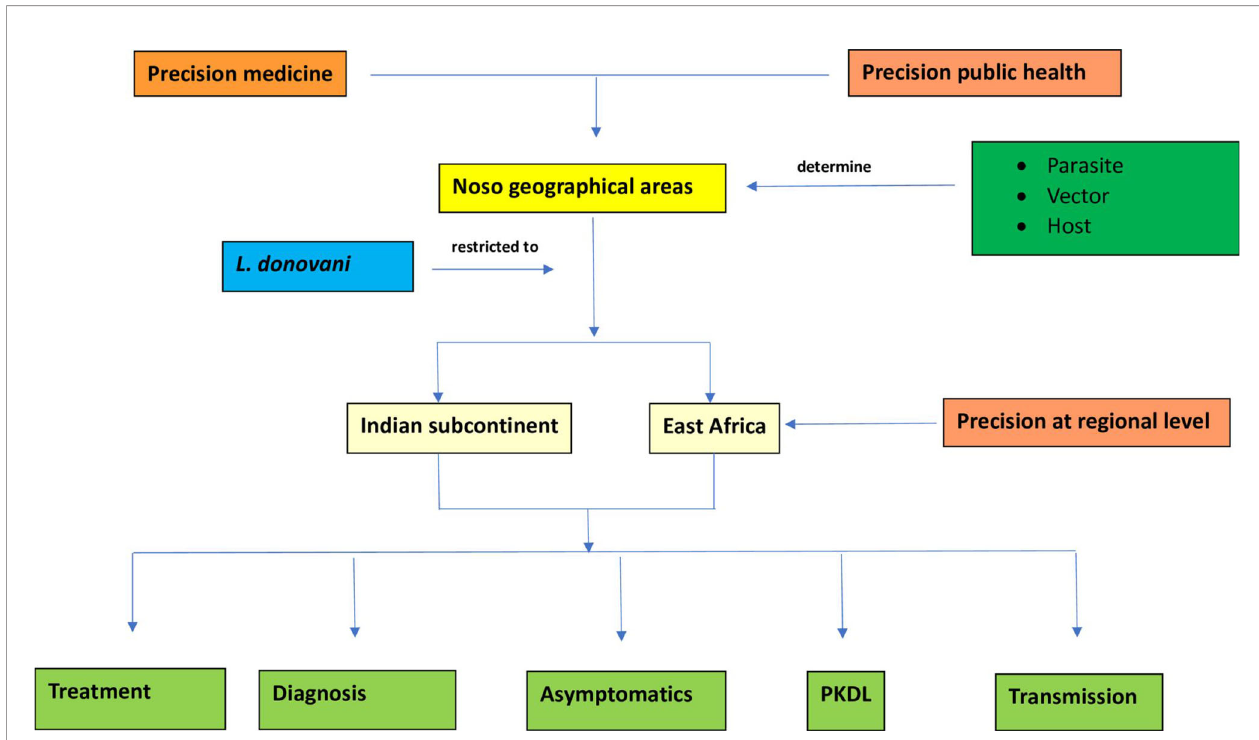
FIGURE 2 | Flowchart describing precision at regional level in visceral leishmaniasis caused by L. donovani through fi ve determinants: treatment, diagnosis, asymptomatics, PKDL and